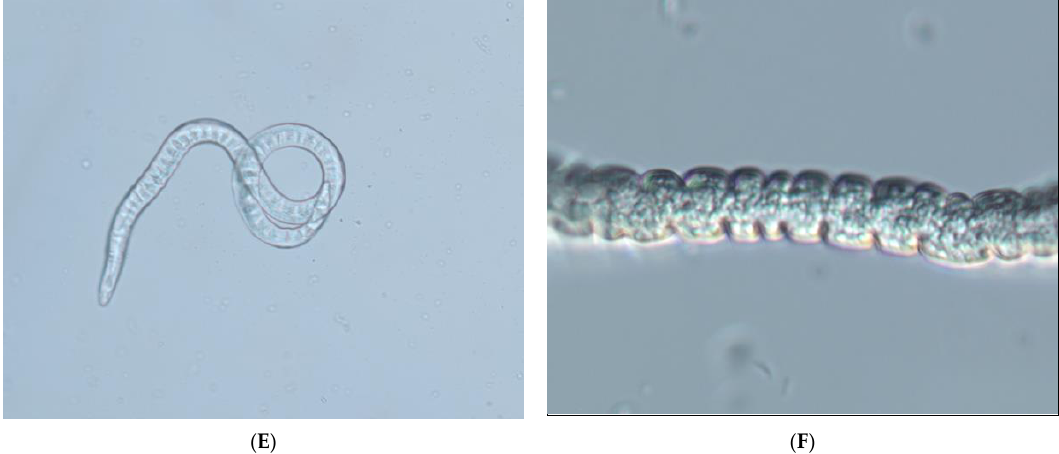
Figure 3. Dehydration and rehydration of Bursaphelenchus xylophilus third-stage dispersal juveniles. ( A ) Rehydration; ( B ) start of dehydration; ( C ) early dehydration; ( D ) later dehydration; ( E ) complete dehydration; ( F ) magnified view showing the body surface of a dehydrated B. xylophilus.